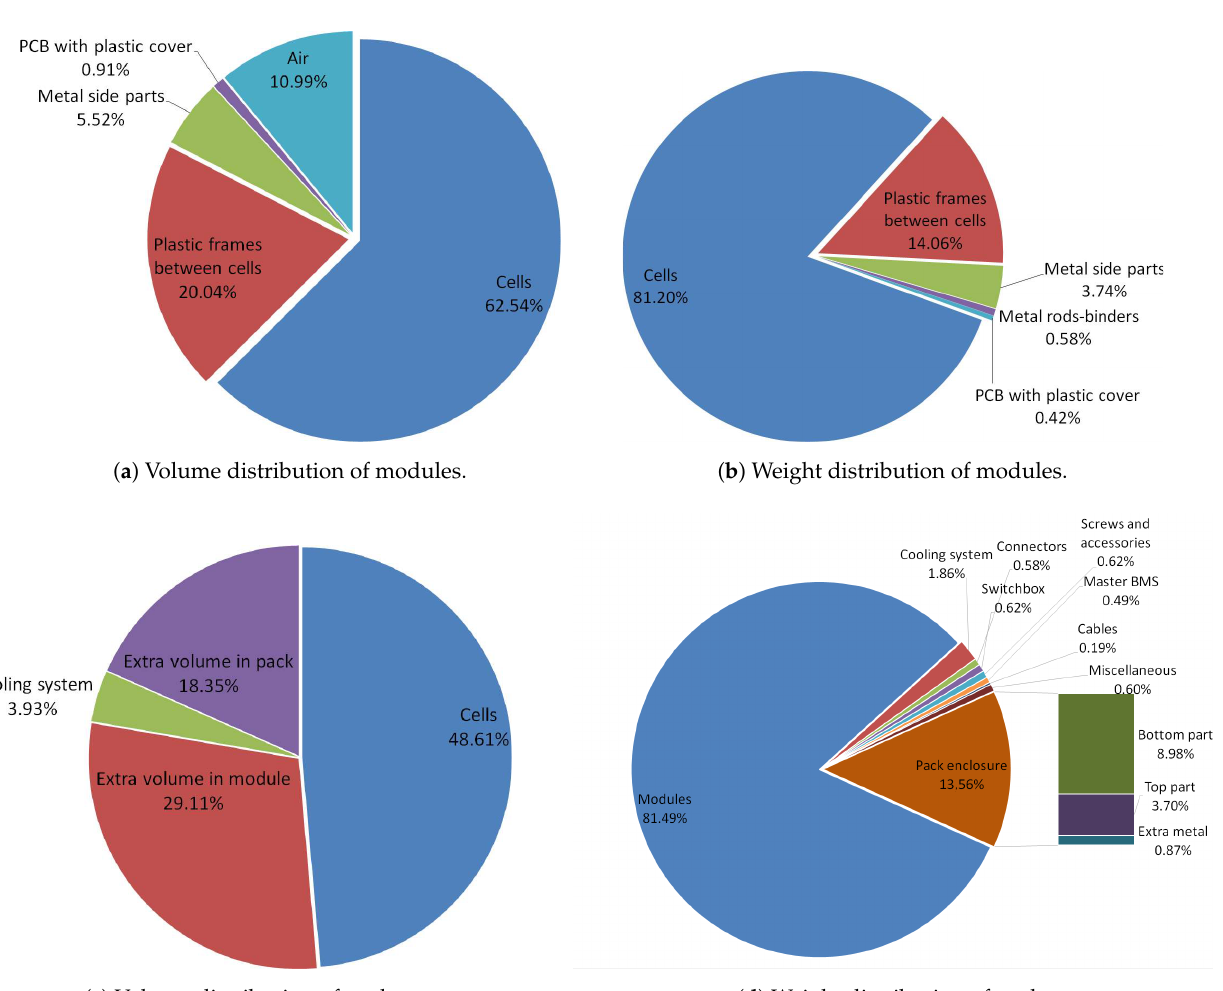
Figure 7. Volume and weight distributions of the Smart e.d. battery pack.